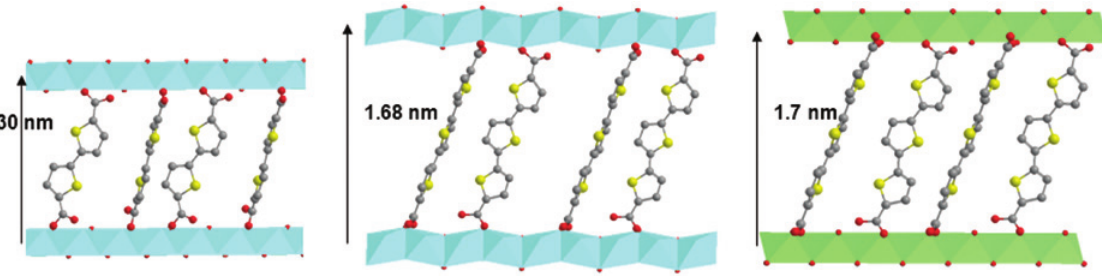
Figure 18: Schematic representation of the compounds Cu-T2 (derived from the Brucite structure), Cu-T3 (derived from the structure of Cu (OH) NO ) and Ni-T3 or Co-T3 (derived from the Brucite structure). Water molecules are omitted. 2 3 3